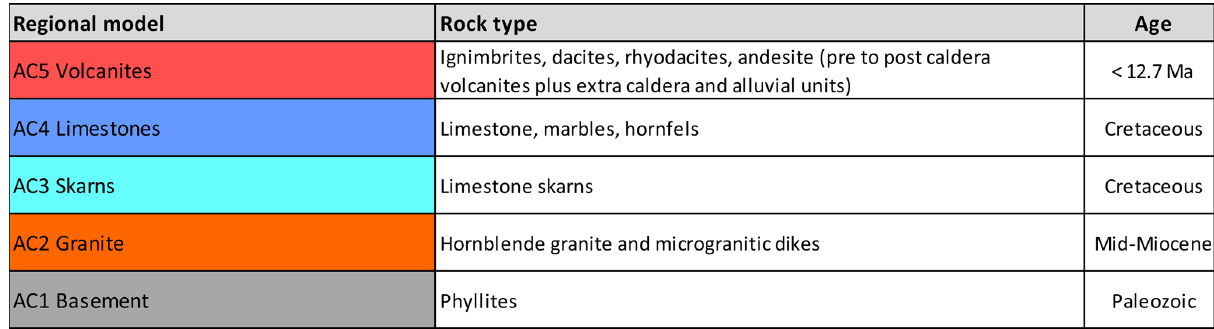
Figure 6. Regional model units of the 3D geological model of Acoculco (slightly modified from Calcagno et al.,